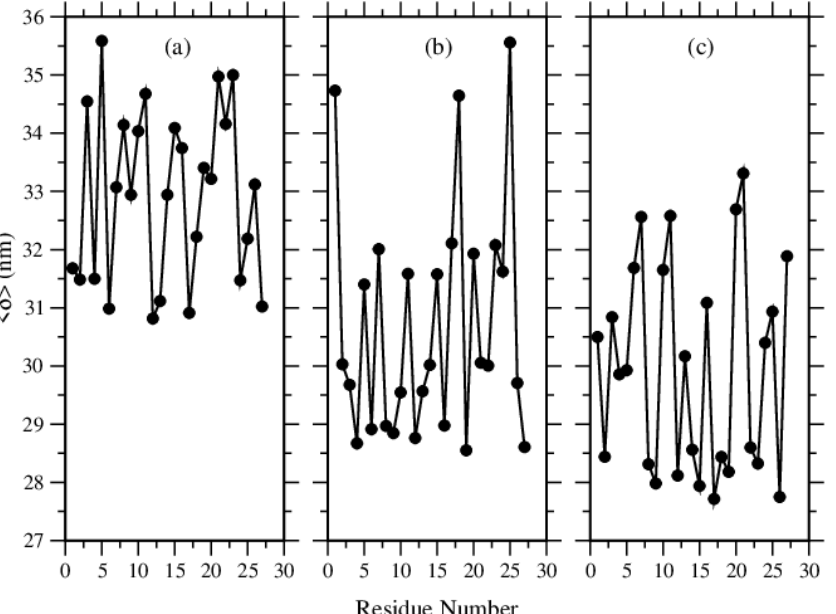
Figure 14. Time averaging deviations of the molecules around their own average locations, for ( a ) Phe, ( b ) Tyr, and ( c ) Trp